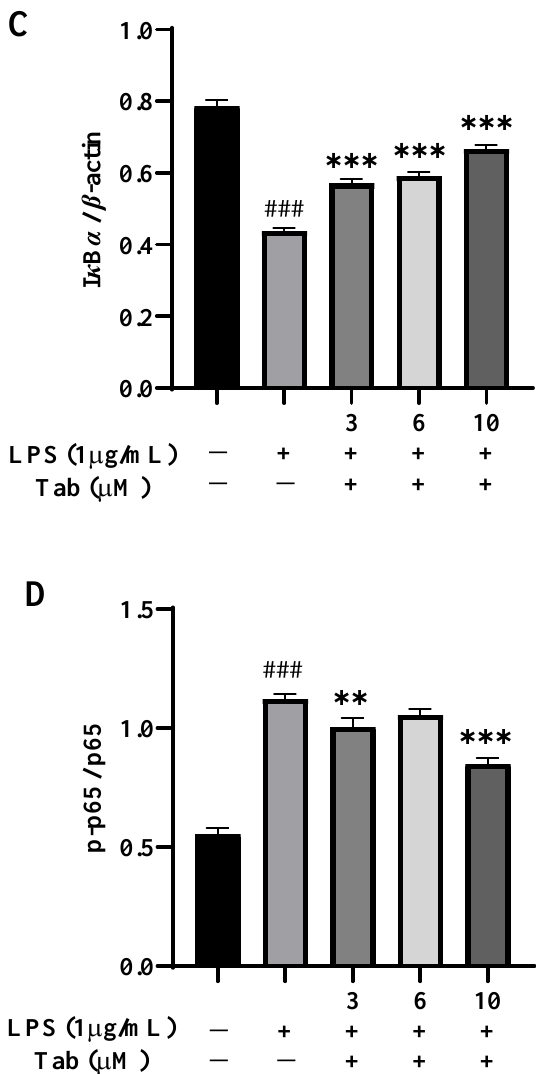
Figure 5. Tab inhibits LPS-induced microglia activation through NF- κ B pathways. BV2 cells were treated with Tab (3, 6, and 10 µ M) for 4 h followed by the treatment with LPS (1 µ g/mL) for 1 h. ( A ) The effect of Tab on the expression of p-p65, p65, I κ B α , p-IKK, and IKK was detected by Western blot. ( B – D ) The relative expression of p-IKK/IKK, I κ B α , and p-p65/p65 in ( A ). ### p < 0.001 vs. untreated control cells; ** p < 0.01 and *** p < 0.001 vs. LPS-treated cells.